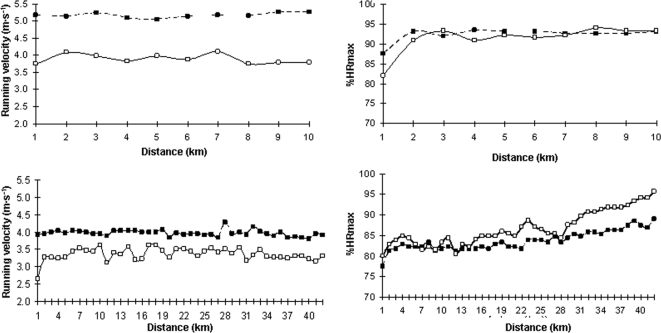
Running velocity (top/left Figure) and average intensity of effort (expressed as mean % of maximal heart rate (%HRmax)) for each kilometric check point (top/right) in two runners of differing ability during a 10 km race (finishing time of ∼32 (symbol = ▪) vs. ∼43 min (symbol = □); and running velocity (bottom/left) and average mean %HRmax for each kilometric check point (bottom/right) in two runners of differing ability during a marathon race (finishing time <3 h (▪) vs. >3 h 30 min (□)).Collectively the figures demonstrate that the pattern of %HRmax increase during competition is very similar regardless of running ability.